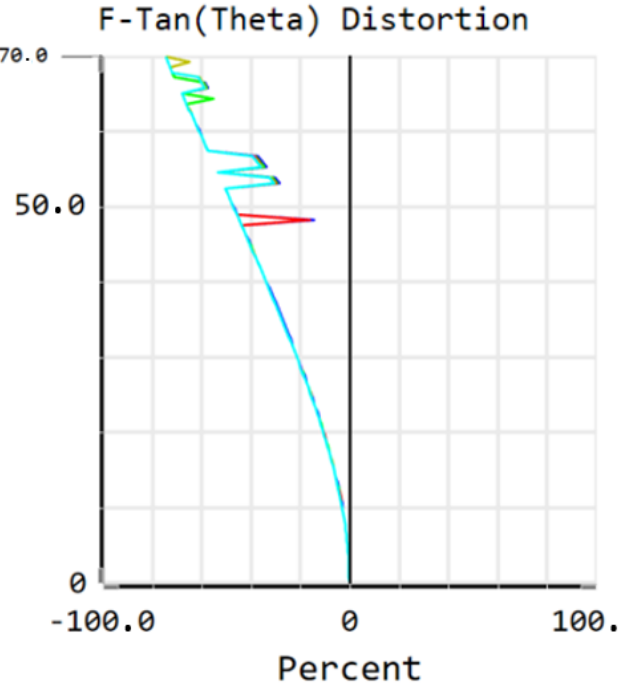
Figure 4. Barrel distortion is the main aberration present in the optical system, due to the wide field-of-view. Distortion is maximal at 70°, where it equals 74.6%. In this graph, the horizontal axis expresses the distortion in %, and the vertical axis gives the half